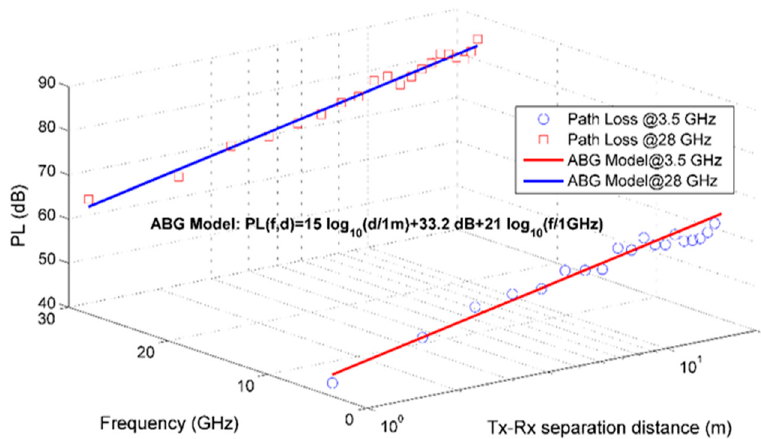
Electronics 2018 , 7 , x FOR PEER REVIEW Figure 6. ABG path loss model versus Tx-Rx separation distance for LOS scenario. Figure 6 . ABG path loss model versus Tx-Rx separation distance for LOS scenario.